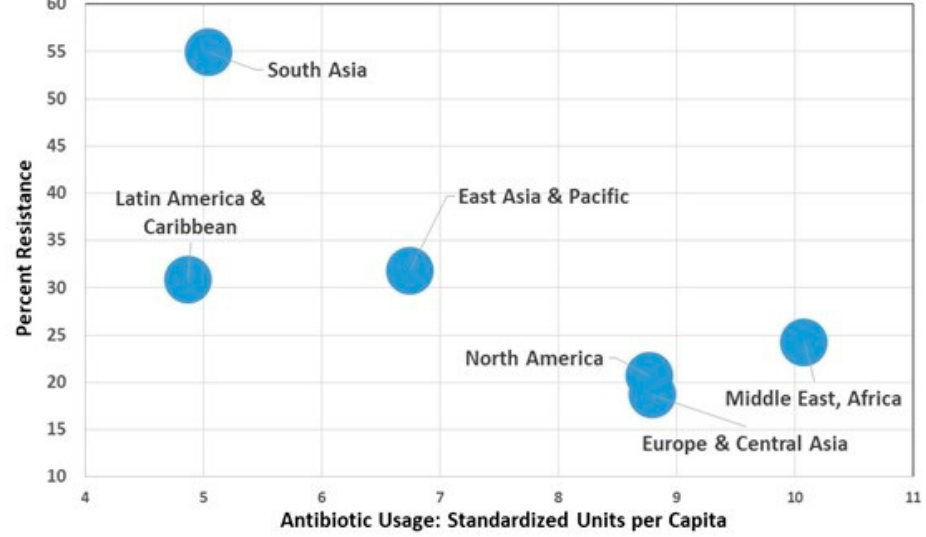
Figure 1. Percent resistance in E. coli to third-generation cephalosporins (3GCeph) and fluoroquinolones (FQ). Source Data: Collignon et al. (2018) [15] and figure from Collignon and McEwen [6].